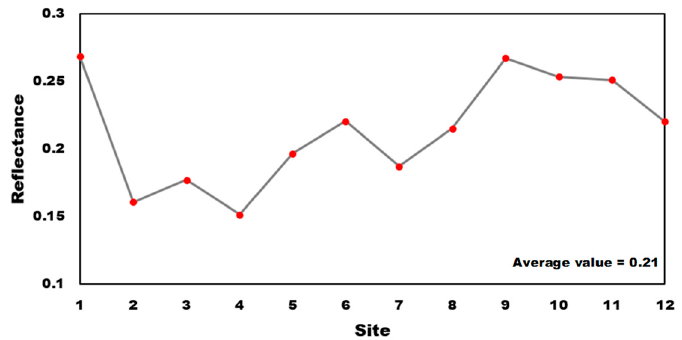
Figure 4. Reflectance values of twelve non forest-covered GLAS footprints which are mentioned in the text with an average value of 0.21.